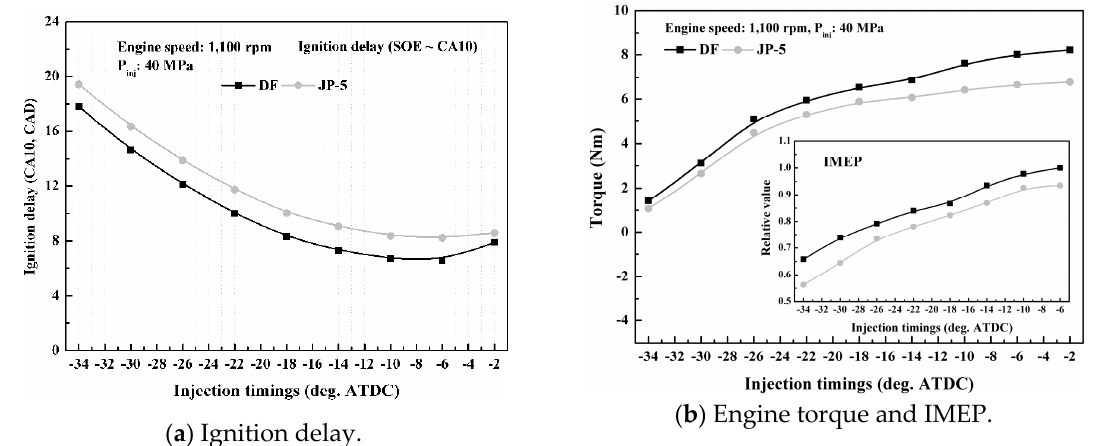
Figure 6. Ignition delay, engine torque, and IMEP characteristics with injection timings .